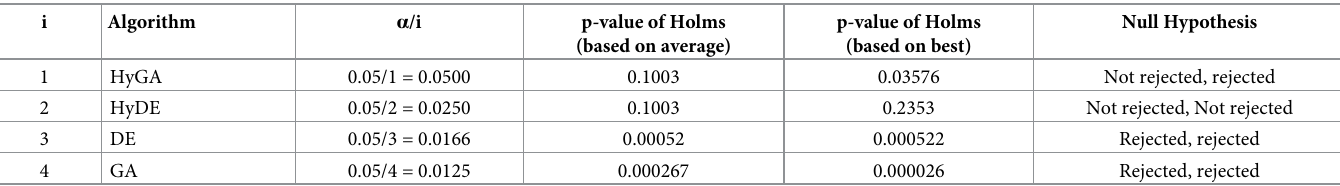
Table 5. Holm’s procedure Adjusted p-value of the methods in the comparison.